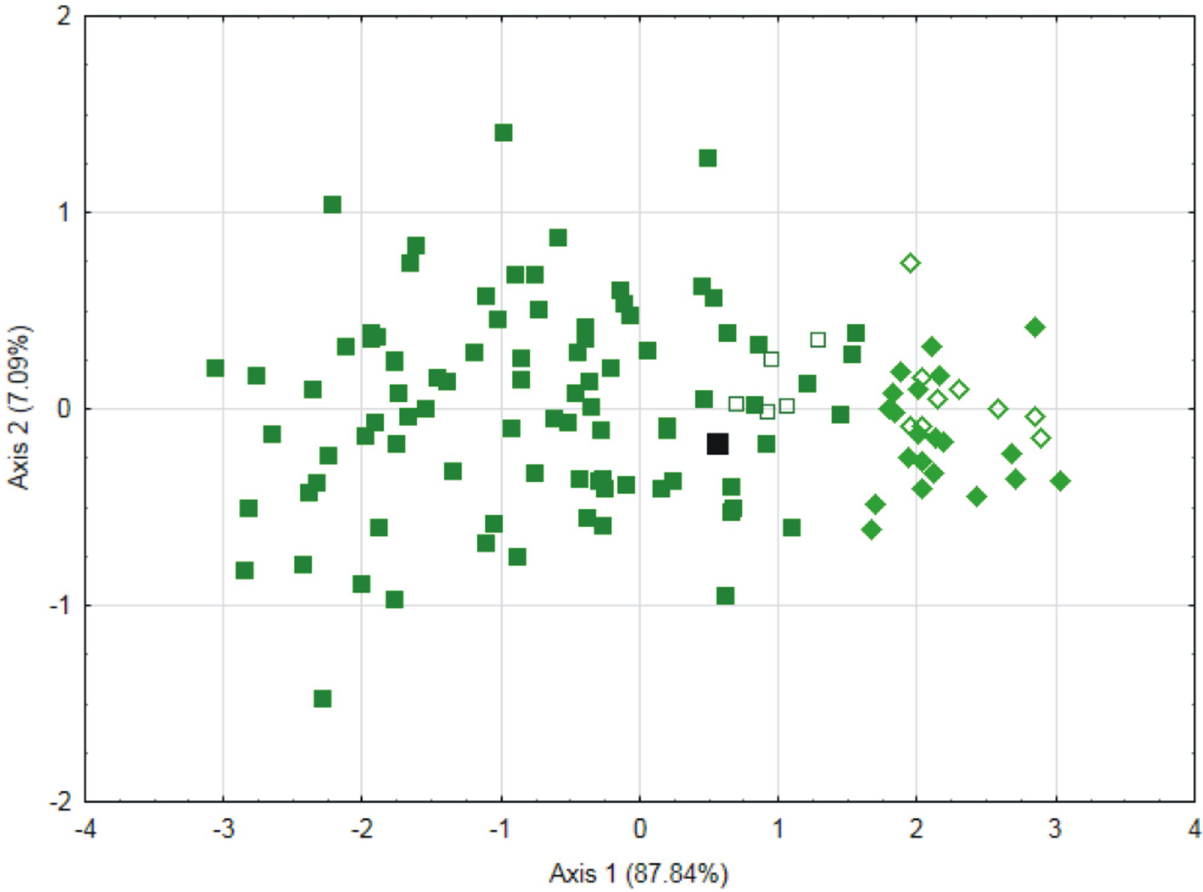
Fig 3. PCA of the leaf cell width and length measurements of P . longisetum and P . angusticellum specimens. Green squares– P . longisetum , white squares–molecularly examined specimens of P . longisetum (Wolski12, Wolski14, Wolski15, Wolski17, Wolski19), black square– P . longisetum type, green rhombus– P . angusticellum , white rhombus–molecularly examined specimens of P . angusticellum (Wolski1, Wolski5, Wolski22-23, Wolski24-26,